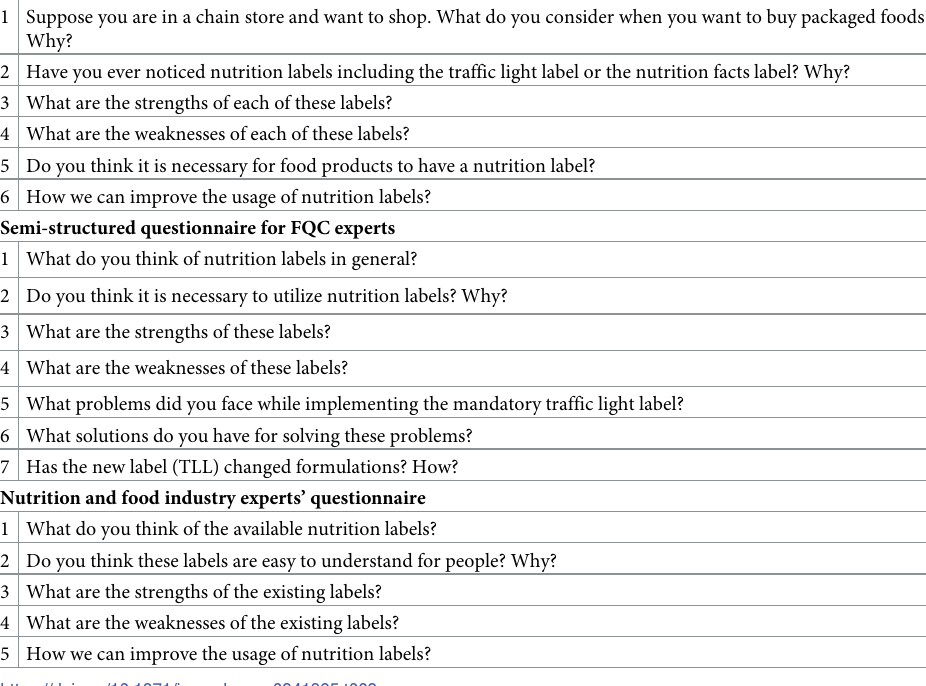
Table 2. Questions asked from